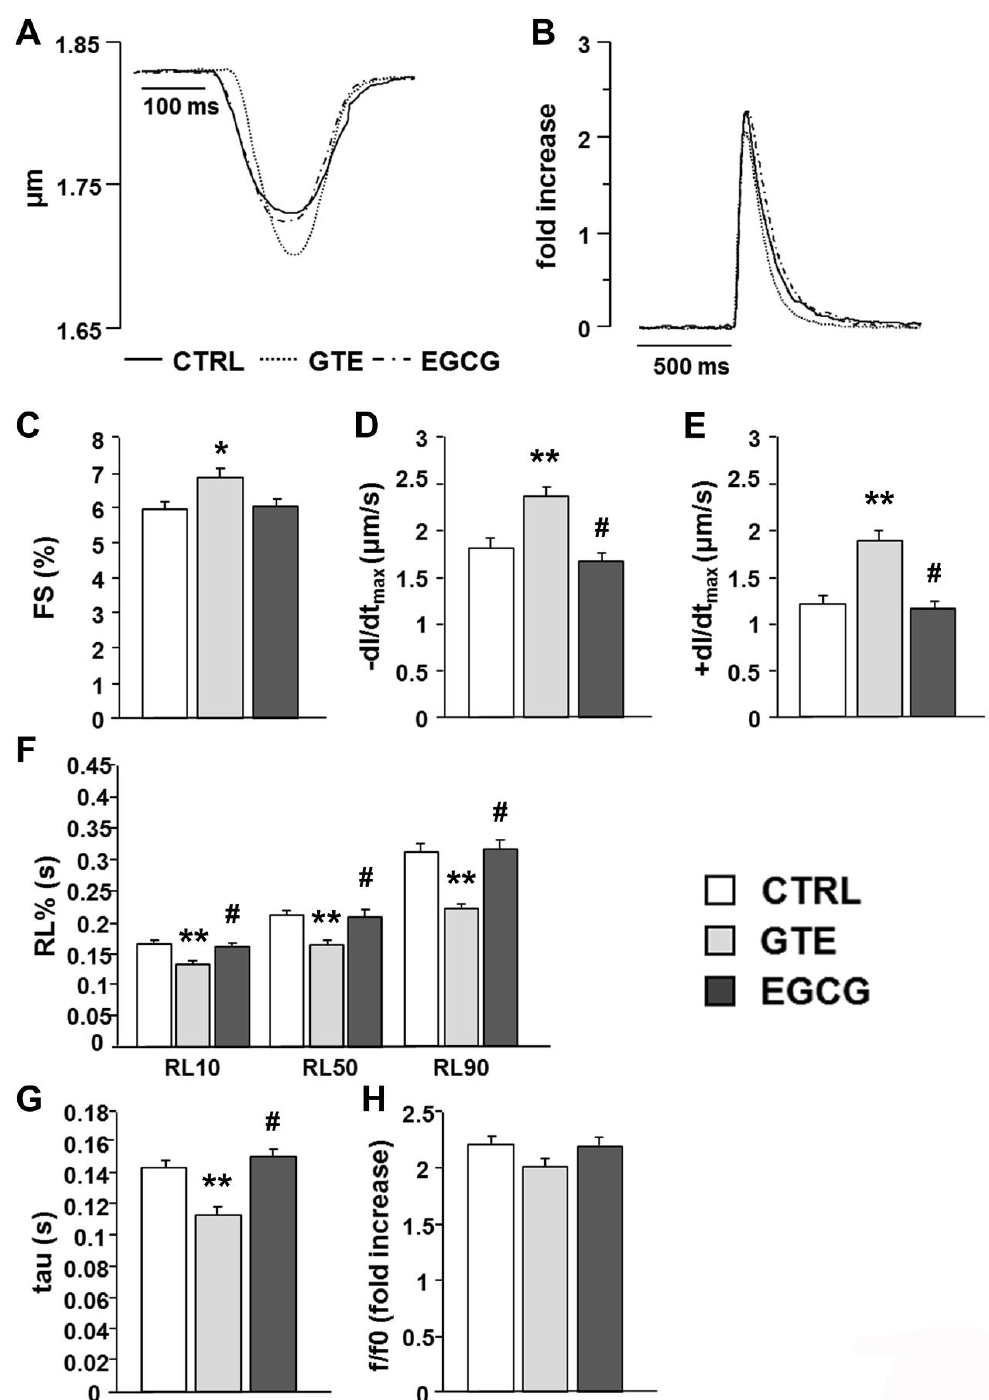
Figure 6. E ff ects of GTE or EGCG administration on cell mechanics and calcium transients. ( A ) Representative examples of sarcomere shortening and ( B ) calcium transients (traces were normalized and expressed as fold increase) recorded in ventricular myocytes from CTRL ( n = 5), GTE ( n = 5), and EGCG rats ( n = 5). ( C – F ) Histograms show the mean ± SEM of the measurements performed in 66 CTRL, 72 GTE, and 78 EGCG cardiomyocytes: ( C ) fraction of shortening (FS); ( D ) maximal rate of shortening ( − dl / dt max ); ( E ) maximal rate of relengthening ( + dl / dt max ); ( F ) time to 10%, 50%, and 90% of relengthening (RL10%, RL50%, and RL90%); ( G ) fluorescence signal decay (tau); ( H ) amplitude of the calcium transient (f / f0). * p < 0.05, ** p < 0.01 indicate significant di ff erences vs. CTRL; # p < 0.01 indicates significant di ff erences between GTE and